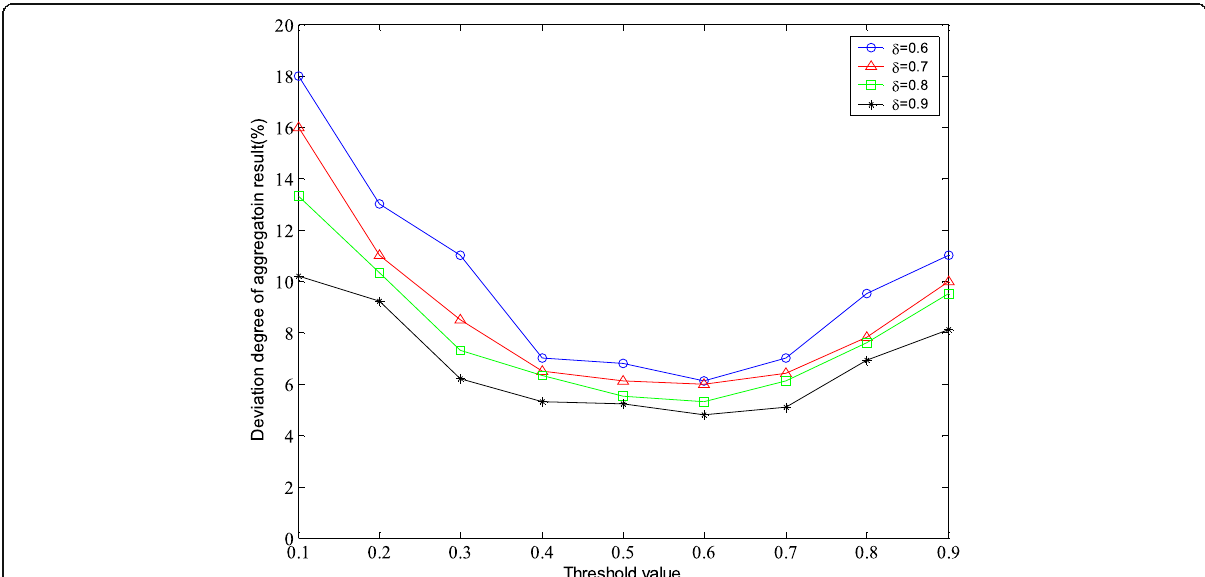
Fig. 3 Deviation degree of aggregation result. Appropriate threshold can be beneficial to detect outliers locally based on the spatial temporal correlations of the sensor ’ s samples